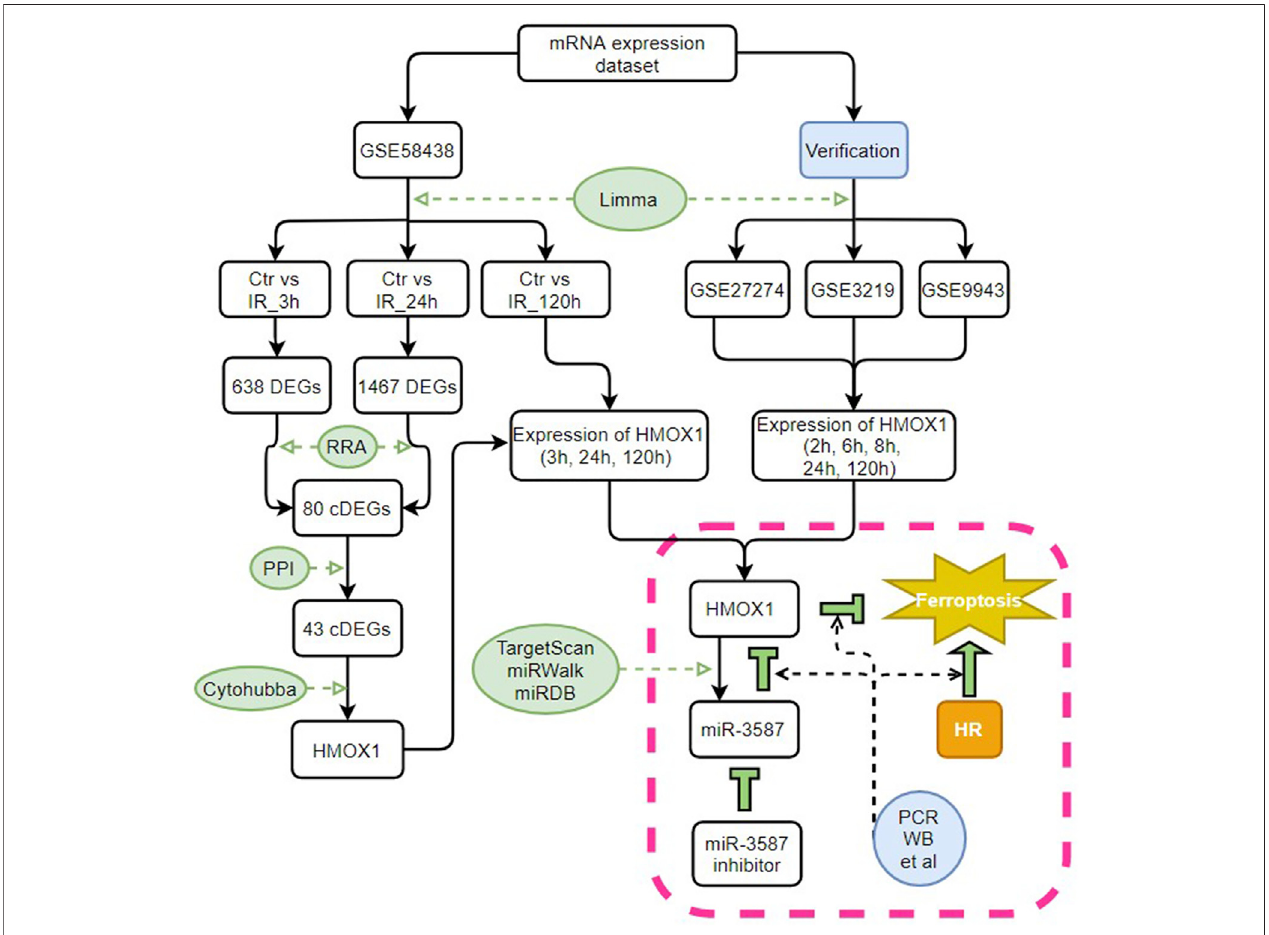
FIGURE 1 | Study fl ow chart. Ctr, control; IR, ischemia-reperfusion; cDEGs, common differentially expressed genes; RRA, RobustRankAggreg; PPI, protein- protein interaction; HMOX1, heme oxygenase 1; miR, microRNA; HR, hypoxia-reoxygenation; PCR, polymerase chain reaction; WB, western blotting.